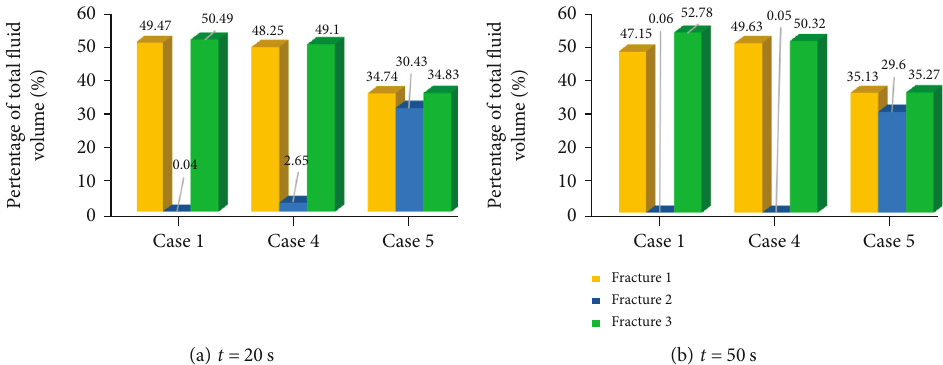
Figure 18: The total fl uid volume distribution of each cluster after pumping for 20 s and 50s for three di ff erent perforation design parameters.